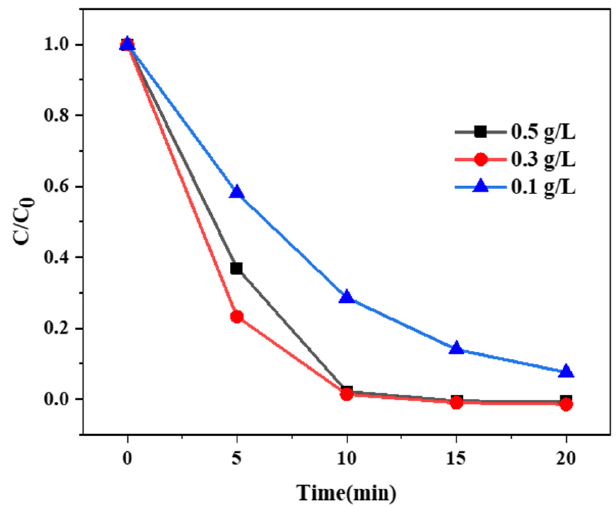
Figure 7. Effect of catalyst dosage on OG degradation. Condition: [OG] = 50 g/L, [PMS] = 3 mM.